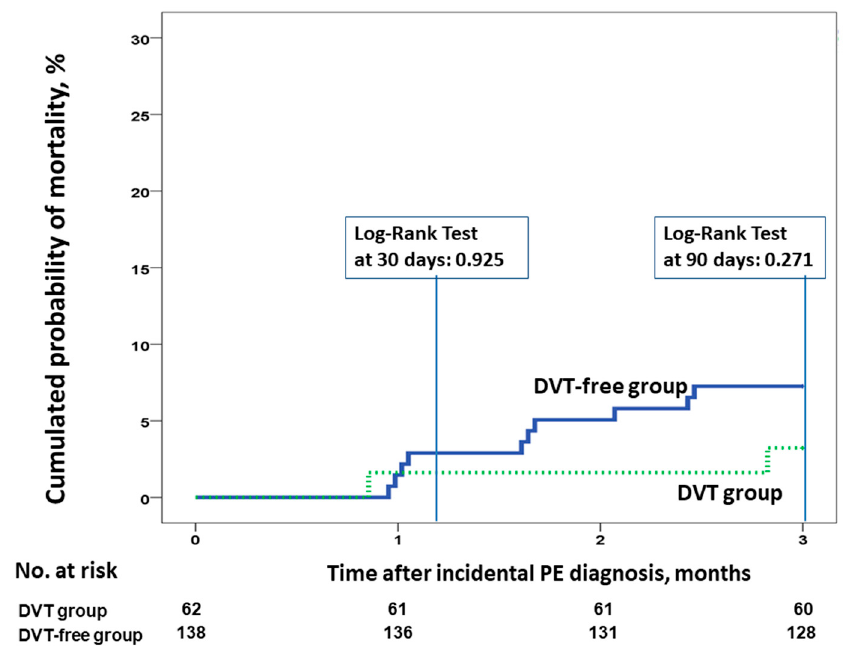
Figure 3. All-cause mortality at 30 and 90 days for patients with incidental PE, according to the presence or absence of concomitant incidental DVT at the time of PE diagnosis. Abbreviations: DVT: deep vein thrombosis; PE: pulmonary embolism. Log-rank p > 0.05.